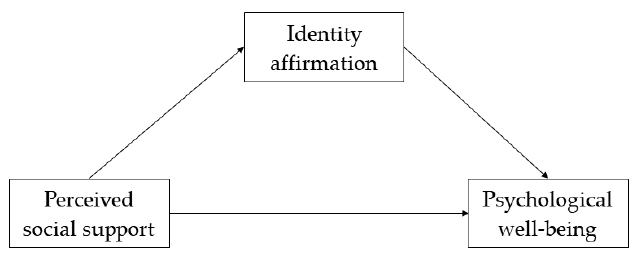
Figure 1. The hypothesized mediation model.